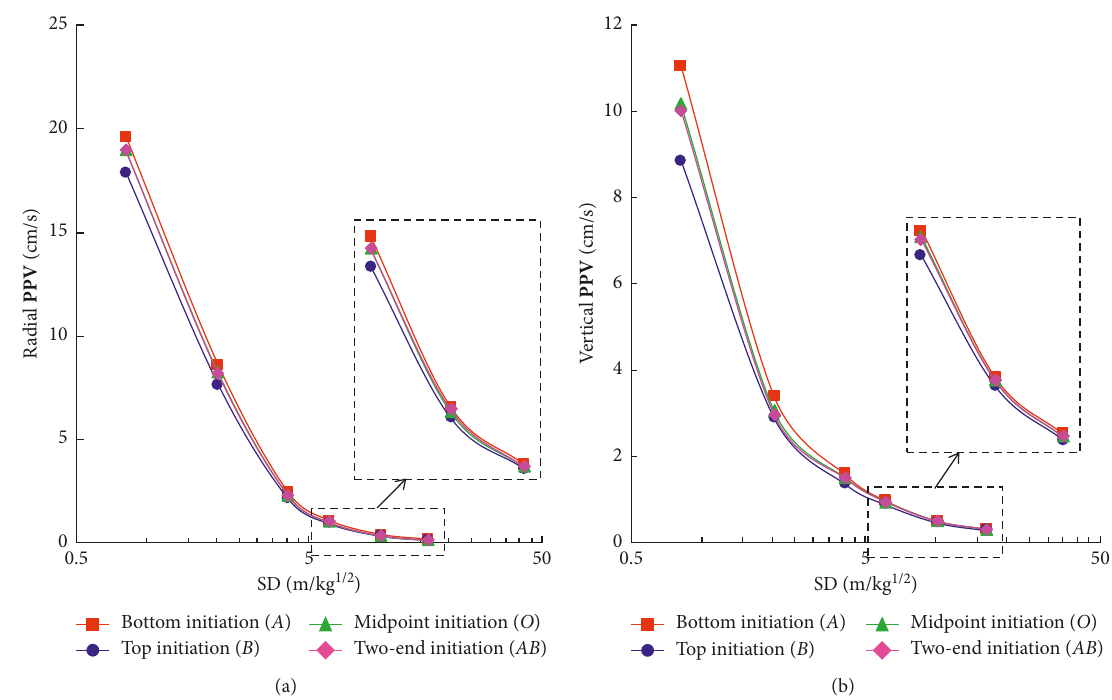
Figure 10: Comparison of PPV s observed along the axial direction of the cylindrical charge. (a) Radial PPV . (b) Vertical PPV